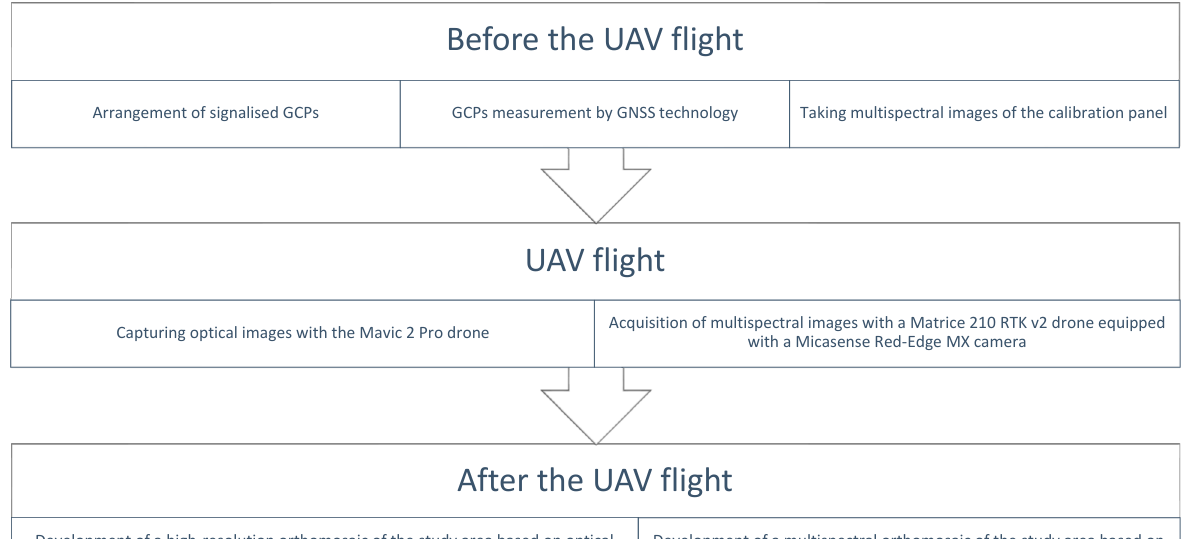
Figure 2. UAV image acquisition workflow.